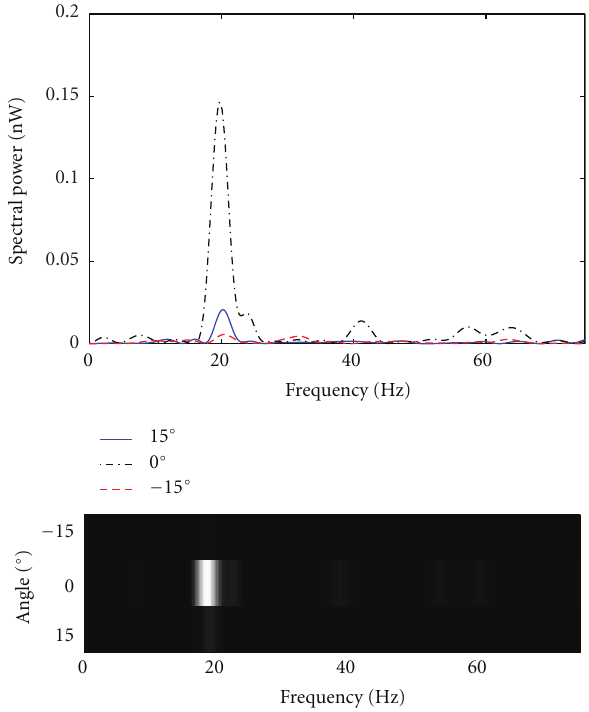
Figure 13: Spectrogram for a person walking towards the observer behind a closed door when the radar is deployed on the human